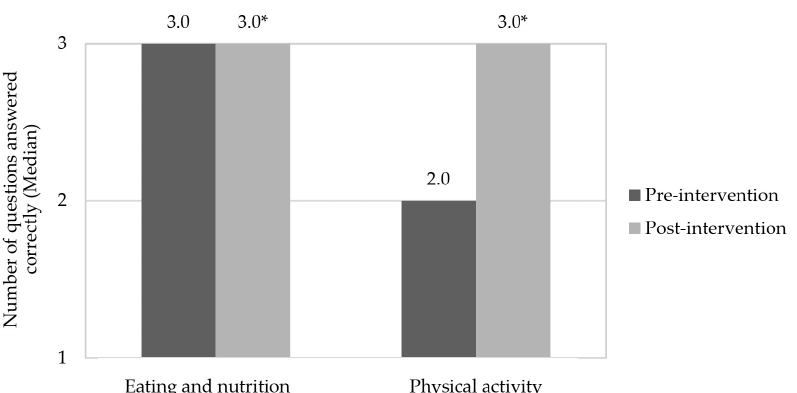
Figure 3. Children’s correct answers to questions in the questionnaires about knowledge of eating, nutrition, and physical activity in the pre- and post-intervention stages. * Indicates a significant difference by Wilcoxon Test ( p -value < 0.05), in relation to the correct answers to questions of the questionnaires about knowledge in eating, nutrition, and physical activity.